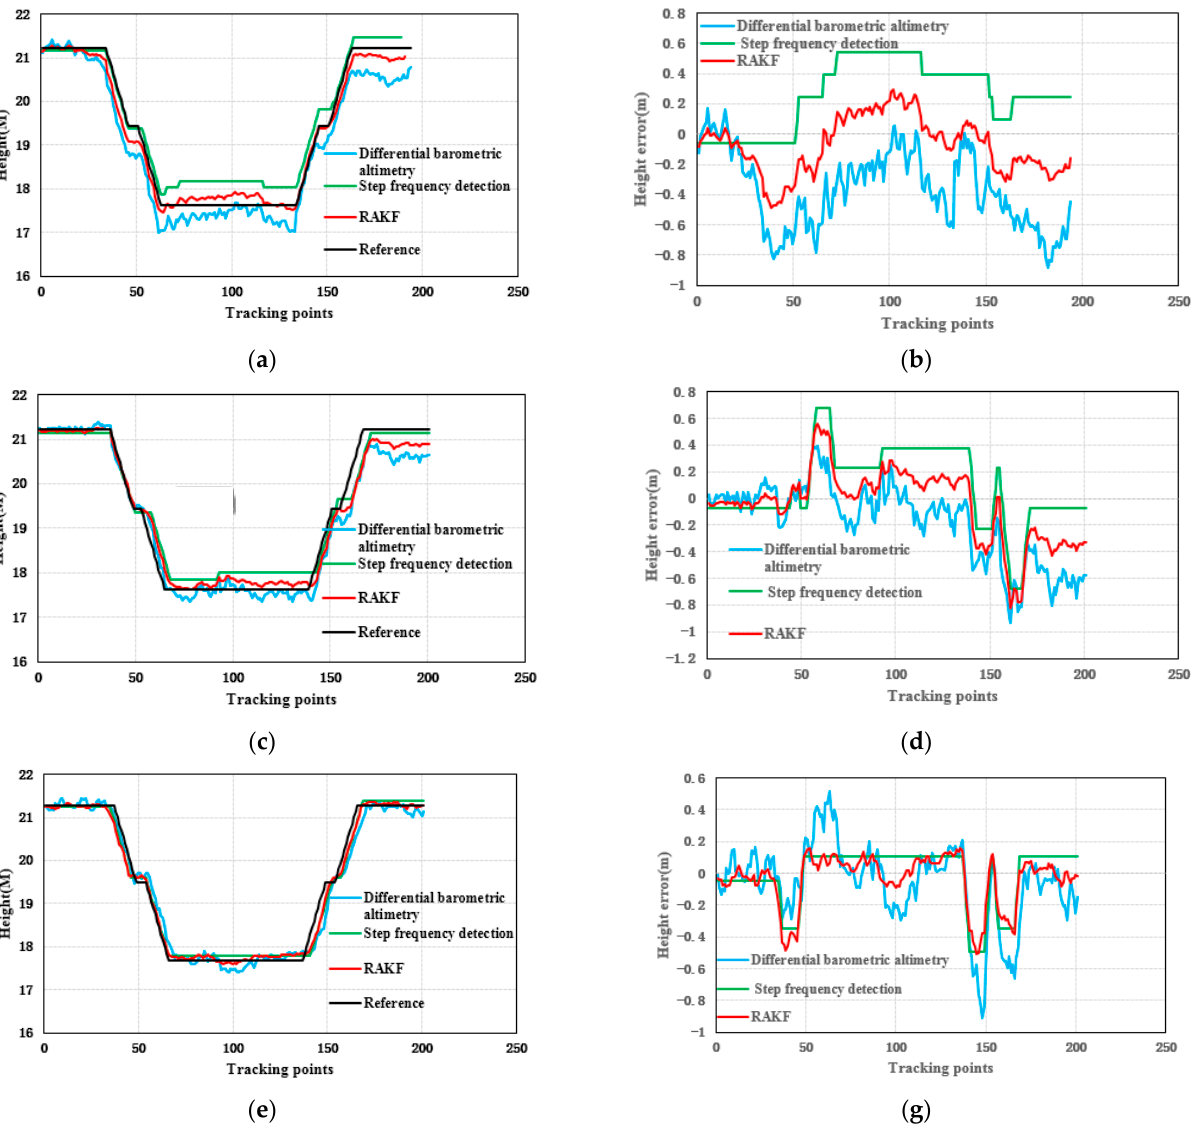
Figure 4. Distributions of the height test for three participants: ( a , b ) participant 1, ( c , d ) participant 2, and ( e , f ) participant 3.